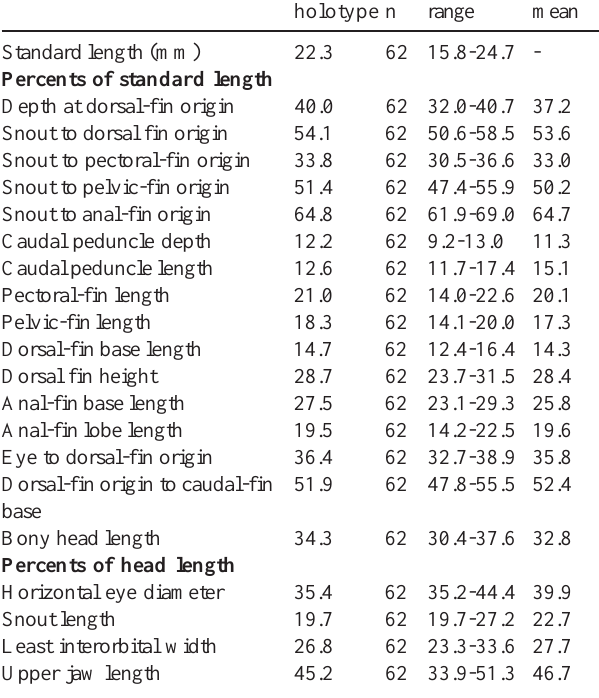
Table 2. Morphometric data for Hyphessobrycon eilyos